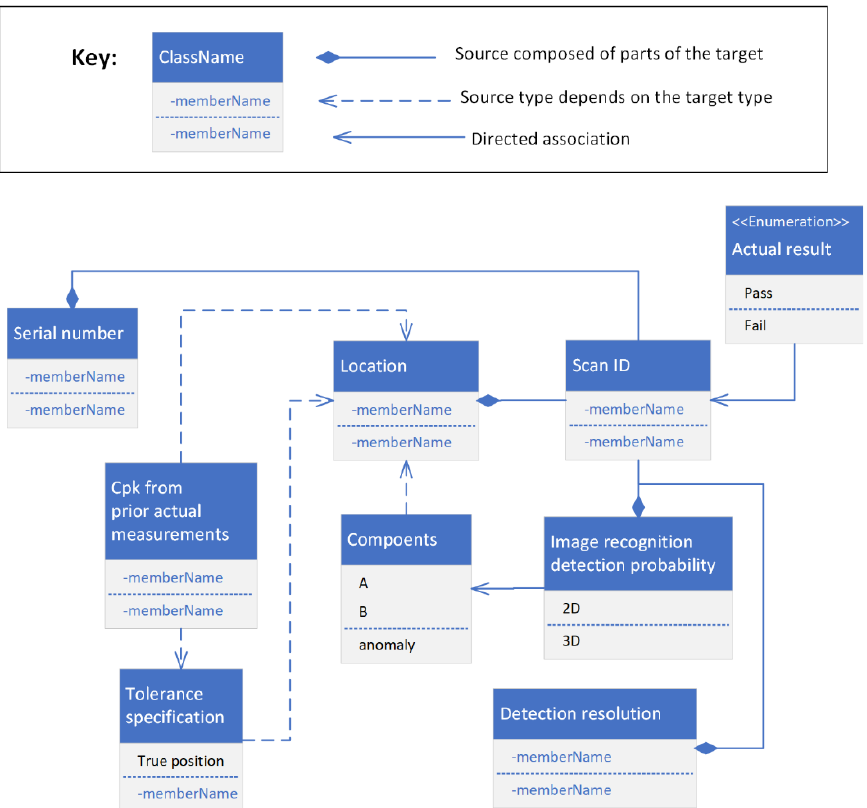
Figure 3. Schema design for data inputs for LeMIIIRC, reprinted from [20].